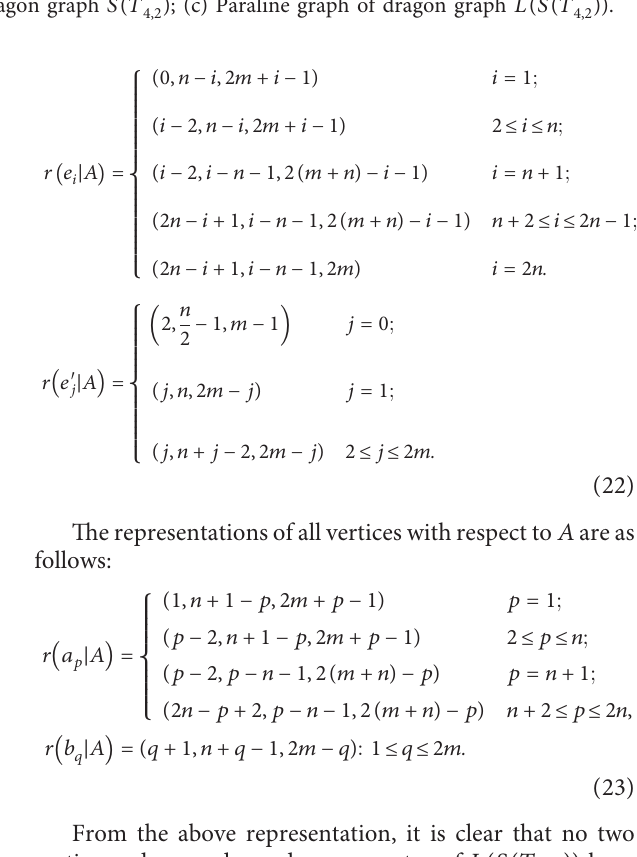
Figure 4: (a) Dragon graph ( T